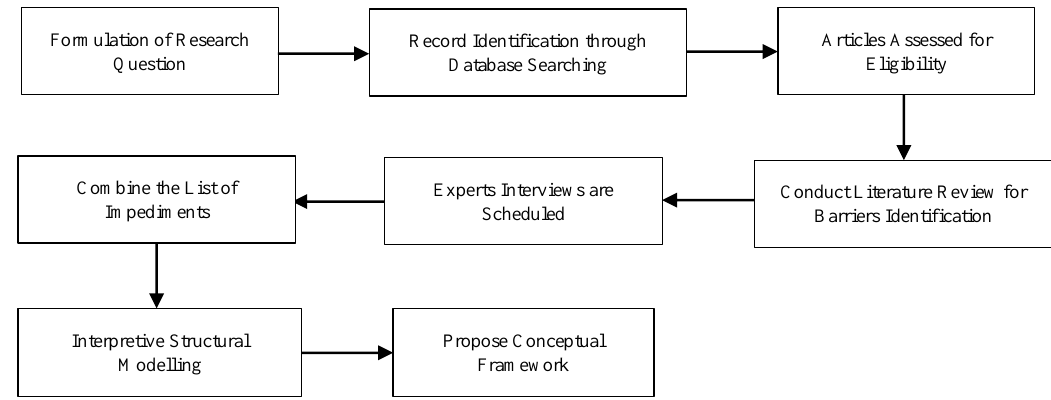
Figure 1. Flowchart of the research